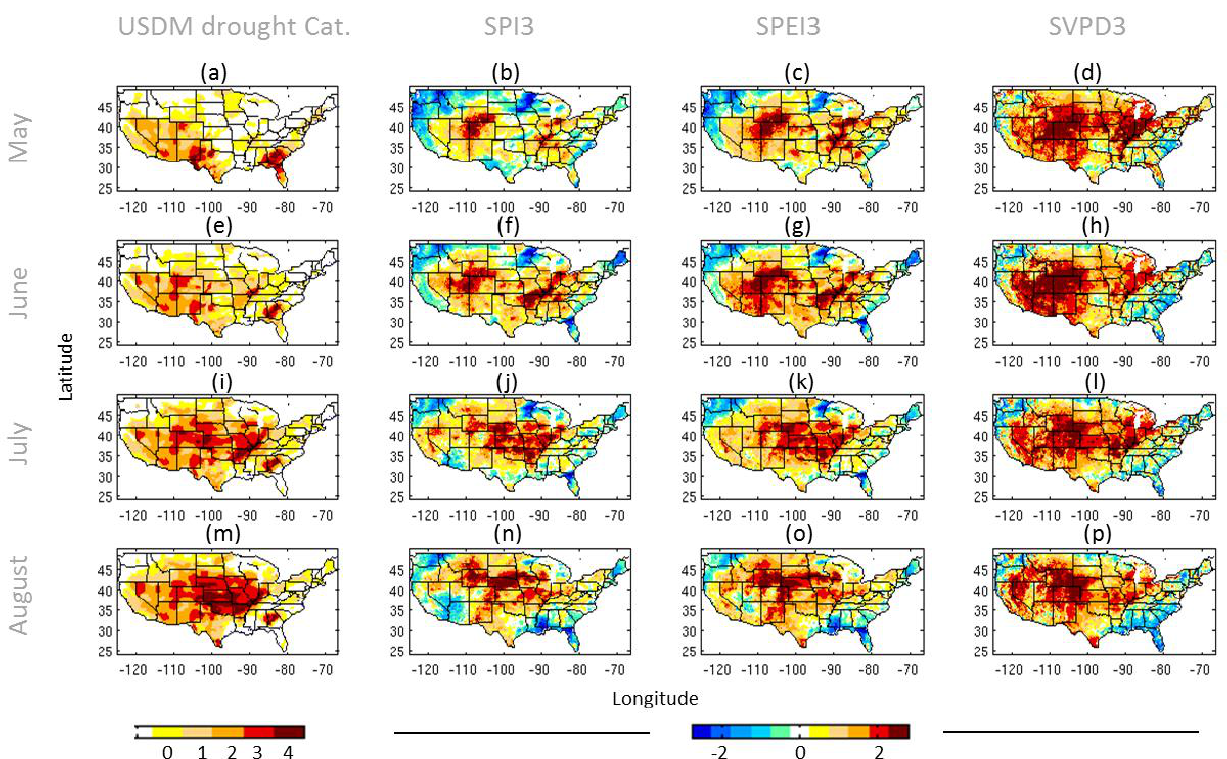
Figure 5. Development of 2012 Midwest US drought based on USDM, SPI3, SPEI3, and SVPD3 from left to right, respectively. From top to bottom the maps correspond to ( a – d ) May, ( e – h ) June, ( i – l ) July, and ( m – p ) August of 2012. For SPI3 and SPEI3 the signs are flipped to facilitate the